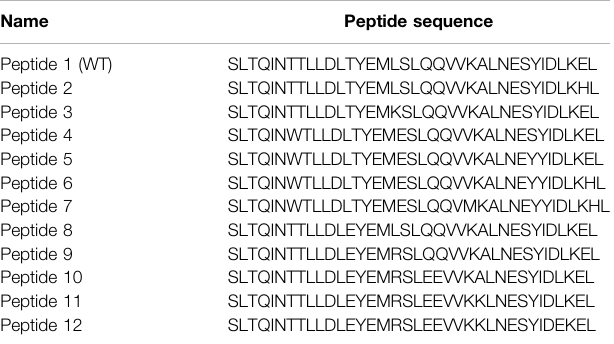
TABLE 1 | The sequence of peptides used in this study. The sites of WT peptide mutations are